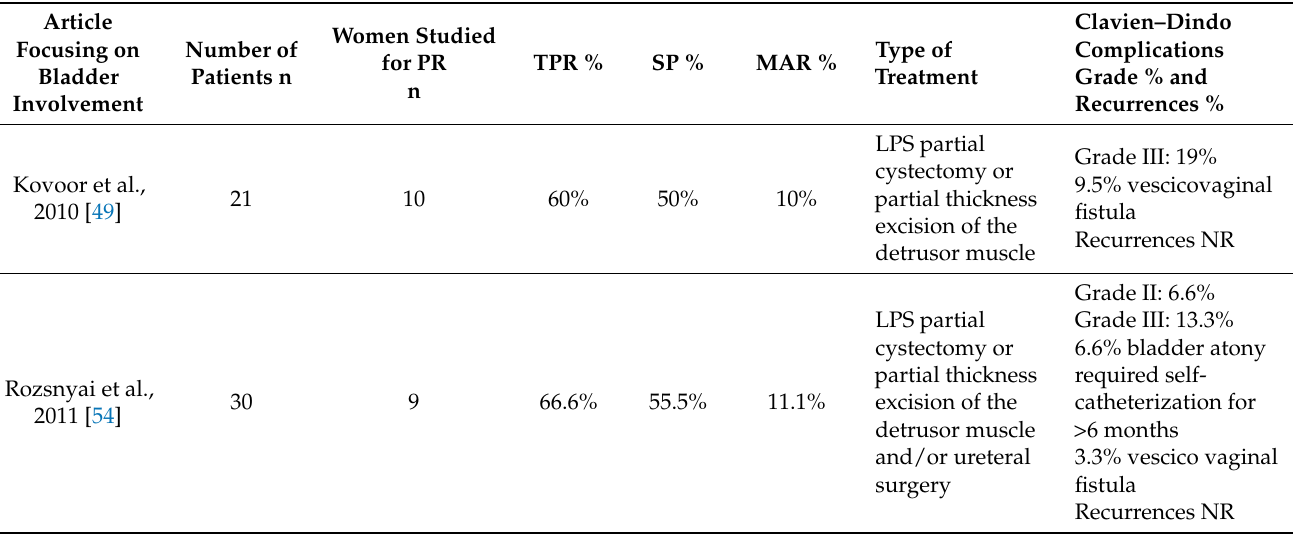
Table 5. Studies on PR, postoperative complications, and recurrences after surgery for bladder deep